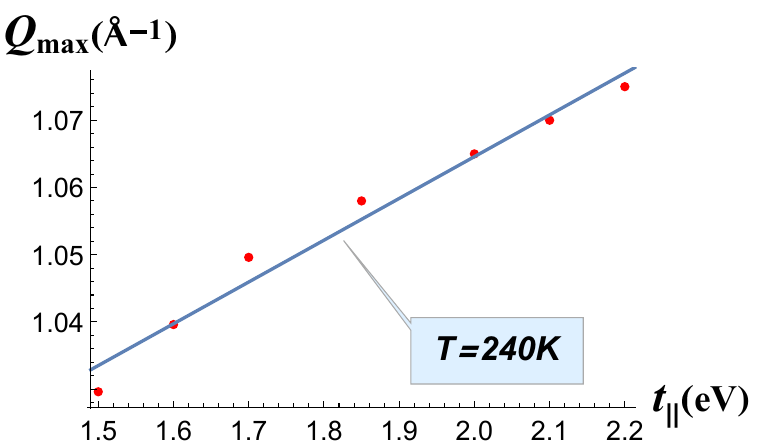
Figure 3. CDW 1 wave vector Q max calculated at T = 240 K as a function of the electron hopping term t (cid:107) .